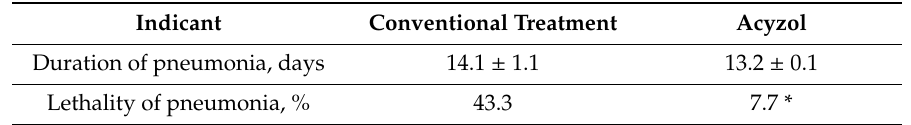
Table 2. Clinical e ffi cacy of using Acyzol in the treatment of pneumonia resulted from of acute poisoning with neurotropic